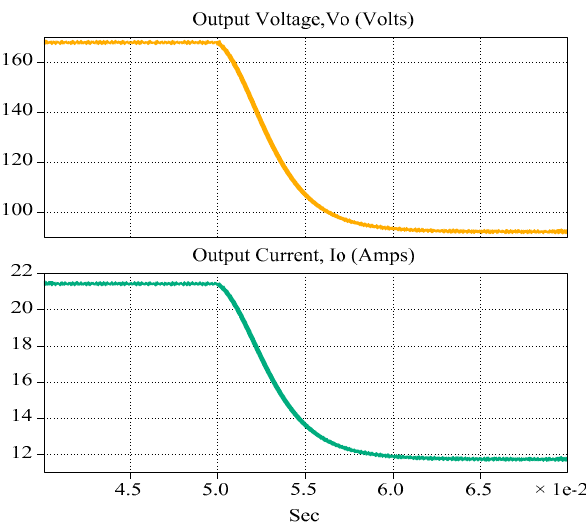
Figure 11. Simulation results for step change in reference voltage.